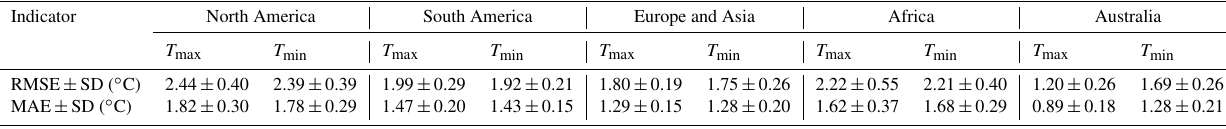
Table 1. Multi-year average accuracies for T max and T min in different regions from 2003 to 2020. Indicator